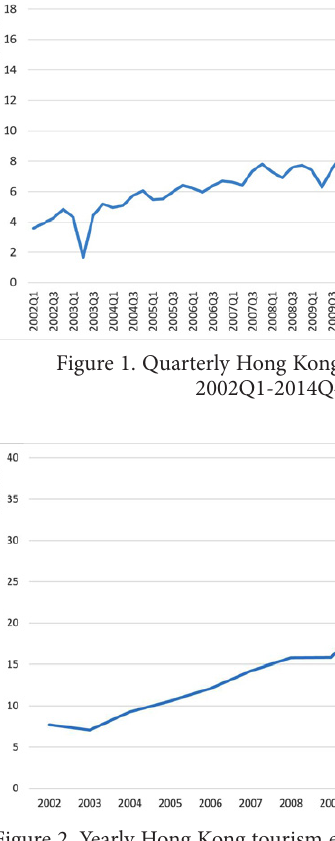
Figure 2. Yearly Hong Kong tourism expenditure,